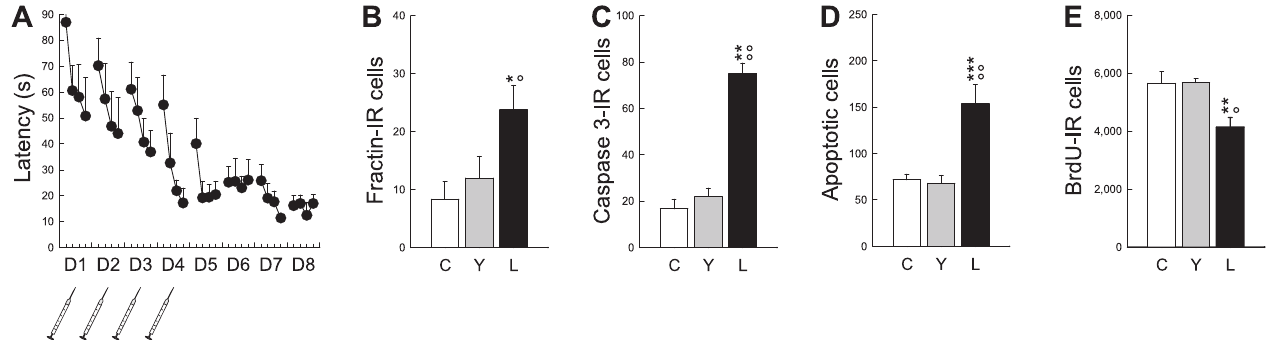
Figure 1. Spatial Learning in a Water Maze Increases Cell Death and Decreases Cell Genesis in the Dentate Gyrus (A) Latency to find the escape platform. The syringes represent BrdU injections. (B–D) Apoptotic cell death measured by the number of fractin-IR cells (B), active-caspase-3-IR cells (C), and both pyknotic and karyorrhexic dying cells (Apoptotic cells) (D). (E) Cell genesis measured by the number of BrdU-IR cells. C, Control group; D, day; L, Learning group; Y, Yoked group. A single asterisk (*) indicates p (cid:2) 0.05, double asterisks (**) indicate p (cid:2) 0.01, and triple asterisks (***) indicate p (cid:2) 0.001 compared to Control. A single circle ( 8 ) indicates p (cid:2) 0.05, double circles ( 88 ) indicate p (cid:2) 0.01 compared to Yoked. Error bars represent the standard error of the mean (s.e.m.). doi:10.1371/journal.pbio.0050214.g001 PLoS Biology |